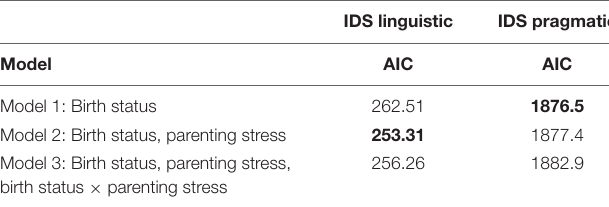
TABLE 6 | Model comparison, effects of birth status and parenting stress: